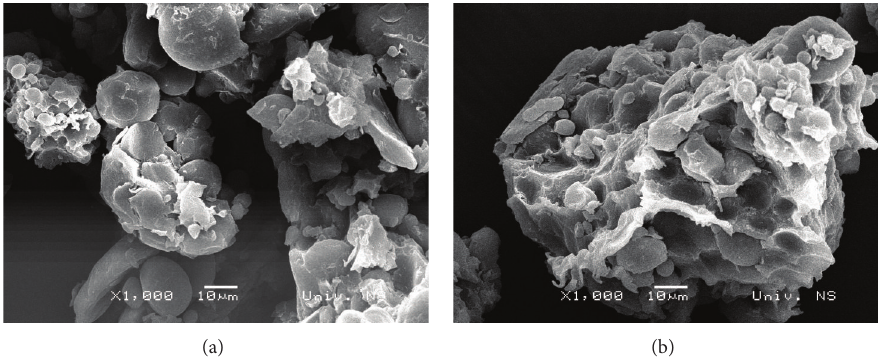
Figure 3: Comparison of micrographs (1000x) of bug-damaged kernel endosperm (a) and the same variety (2) without bug infestation